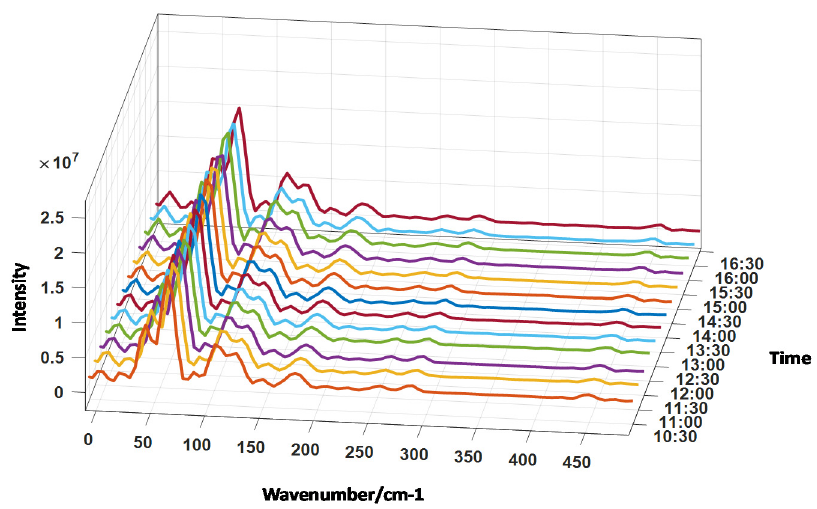
Figure 6 is the spectrum of 2-hydroxy BA at different times (from 10:30 to 16:30 at 30 min intervals). Under the same power and integration time, the signal position and no change, which proves the stability of the system.